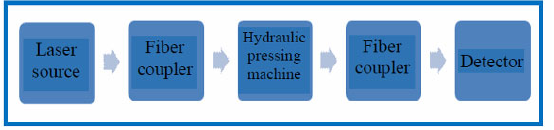
Fig. 9 Block diagram of the experimental setup of piezo-optic pressure